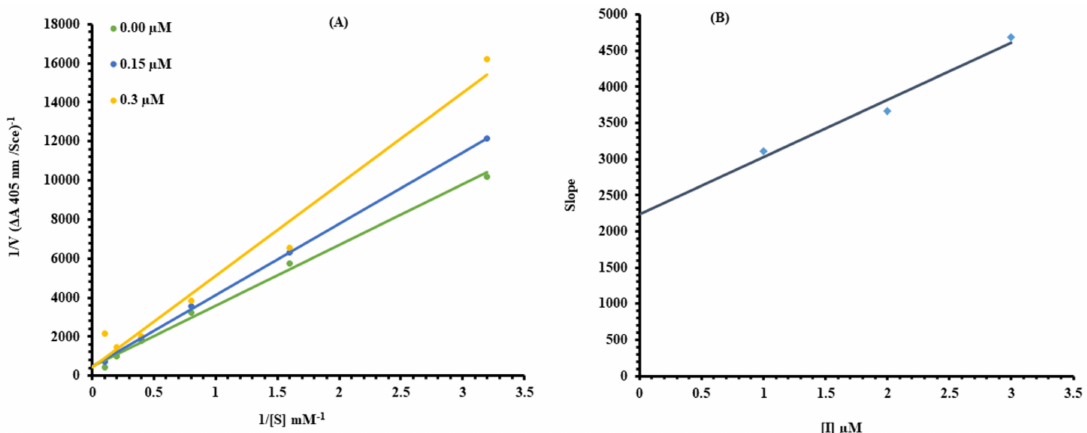
Figure 2. Lineweaver-Burk plots for the inhibition of α -glucosidase by compound 5g ( A ) The tested concentrations of 5g were 0.00, 0.15, and 0.3 µ M; the concentrations of the substrate (p-nitrophenyl- α -D glucopyranoside) were 10, 5, 2.5, 1.25, 0.625, and 0.3125 mM. ( B ) The plots of the slope versus inhibitor concentration are shown as insets and were used to determine the inhibition constants.